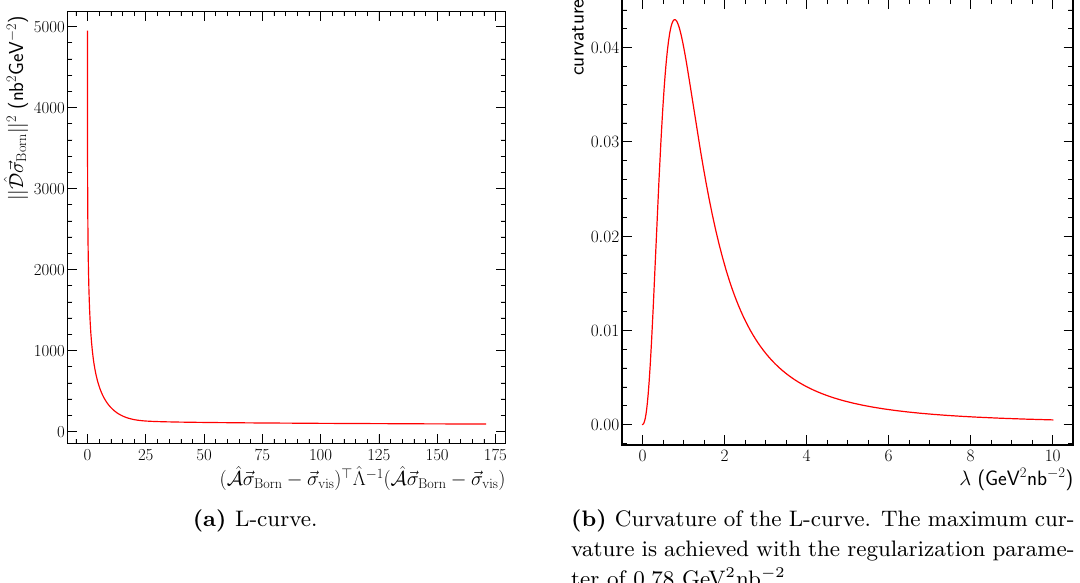
Figure 17. An example of an L-curve and its curvature. The L-curve and its curvature are obtained by solving eq. (1.5) with the parameter σ E = 20